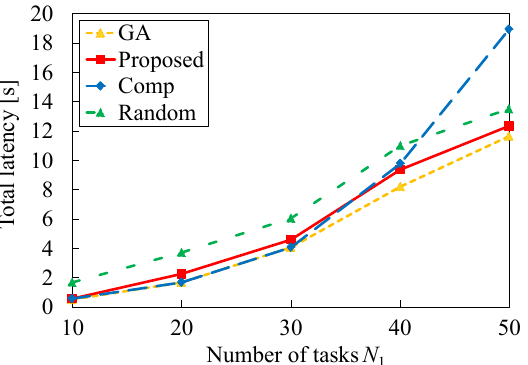
Figure 5. Total latency versus number of tasks in the case of τ = 0.2 and λ =